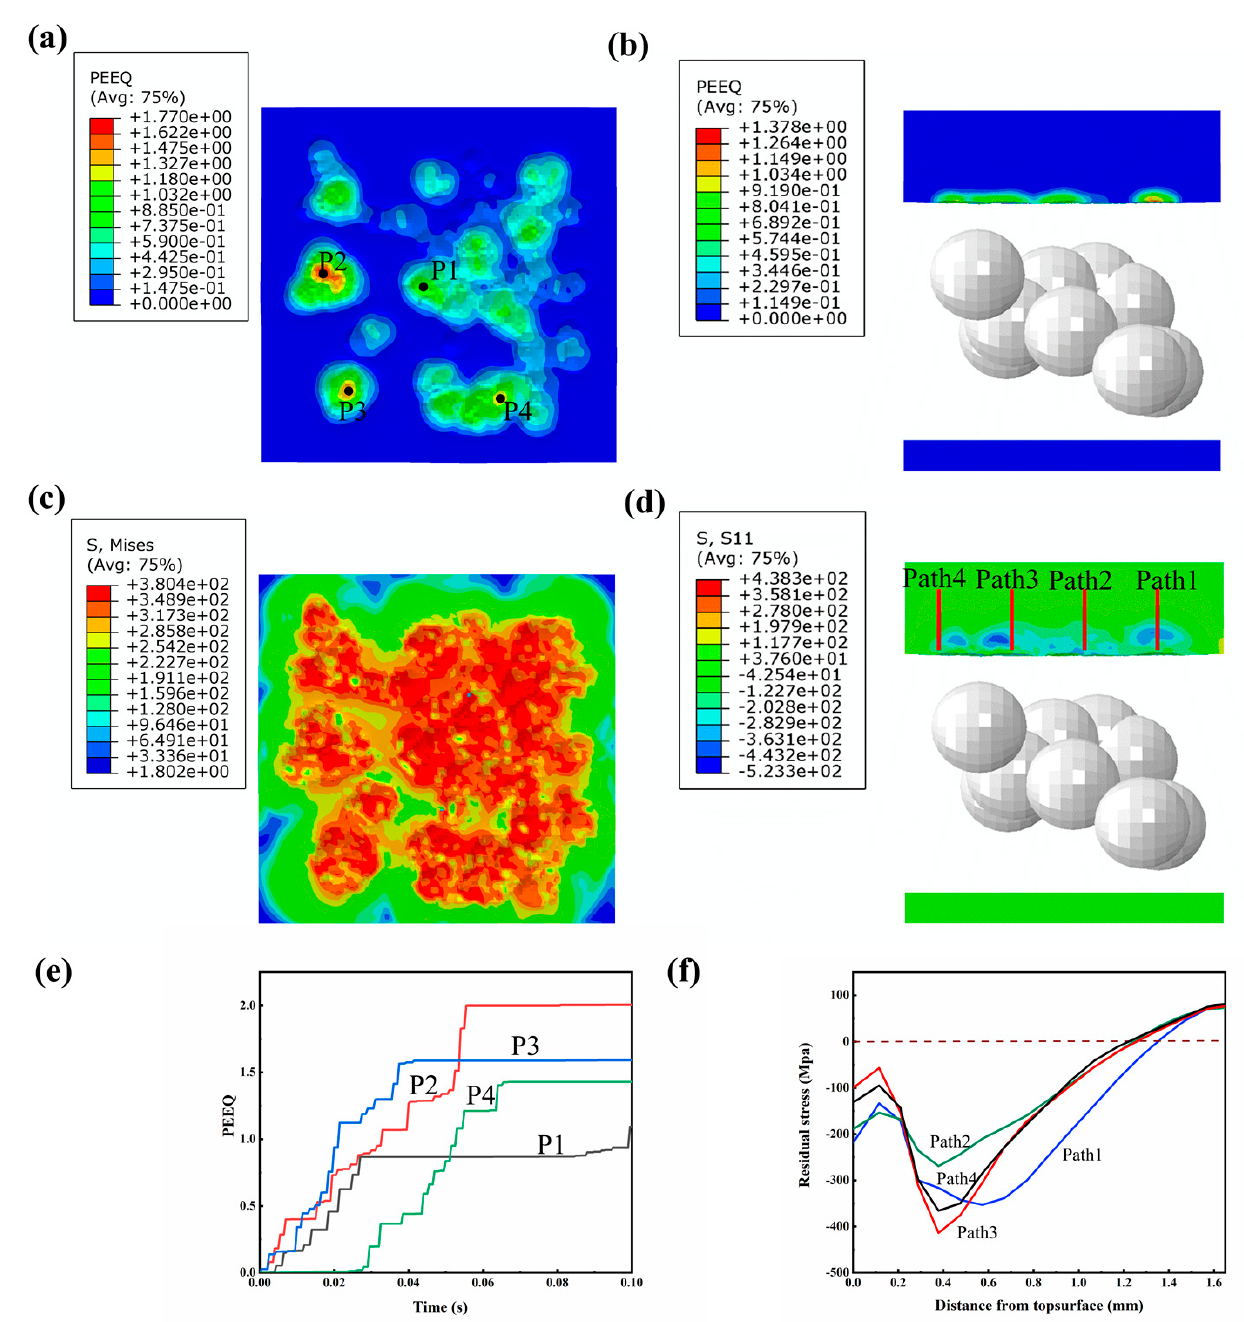
Figure 13. FE simulation of ultrasonic shot peening process of 316L stainless steel with multiple shots for a duration of 0.1 s: ( a ) plane view of PEEQ distribution of 316L stainless sample; ( b ) cross-sectional view of PEEQ distribution of 316L stainless sample; ( c ) plane view of von Mises stress distribution of 316L stainless sample; ( d ) cross-sectional view of von Mises stress distribution of 316L stainless sample; ( e ) accumulated PEEQ with time during the peening process for the four points marked in ( a ); and ( f ) the residual stress distribution of the peened 316L stainless steel along the four paths marked in ( d ).